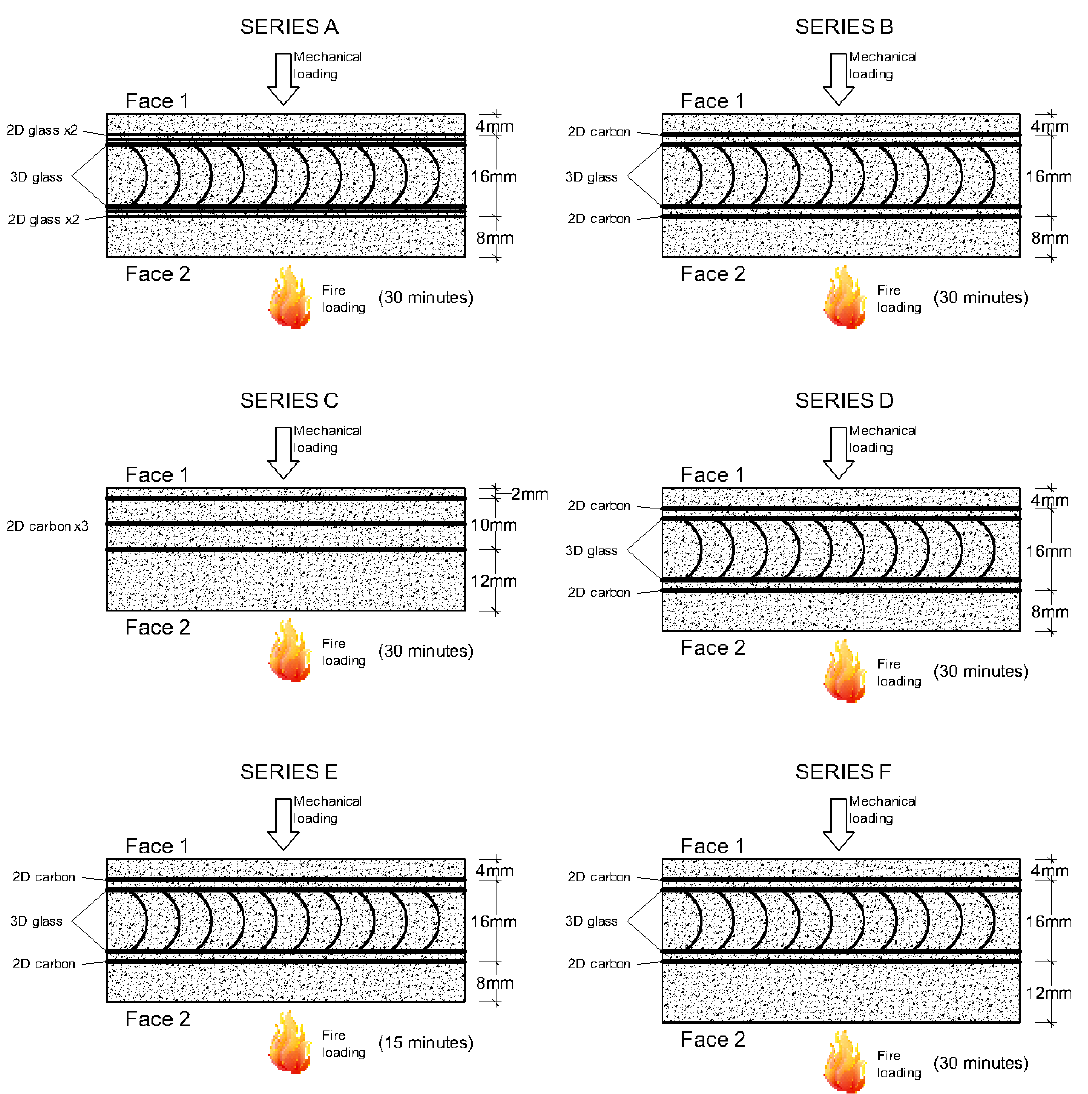
Table 2. Geometrical data and testing parameters for Series A to F.